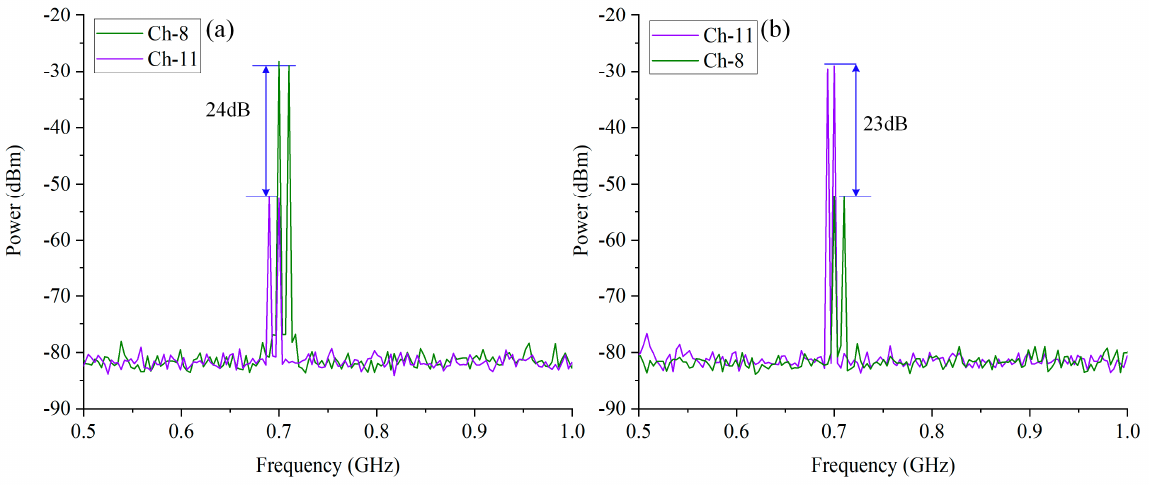
Figure 5. Electrical spectra of ( a ) Ch − 8 as the desired channel and ( b ) Ch − 11 as the desired channel.